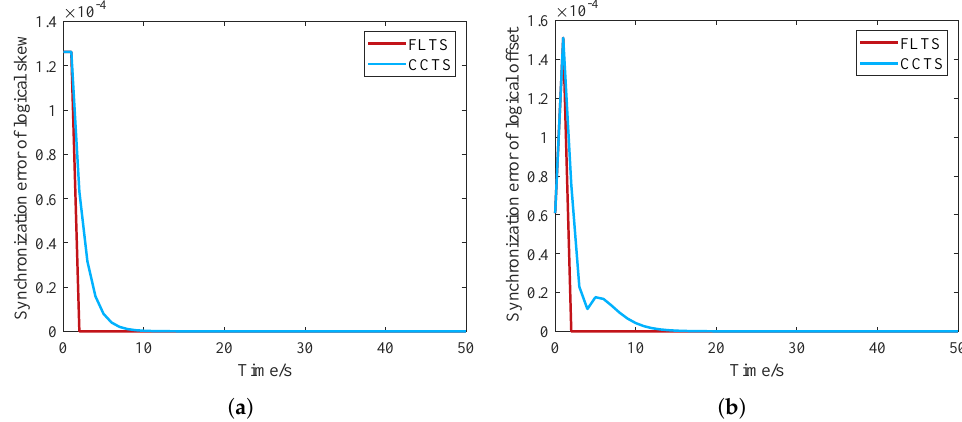
Figure 5. Convergence comparison of the logical clock in intra-cluster synchronization. ( a ) Logical clock skew; ( b ) Logical clock offset.